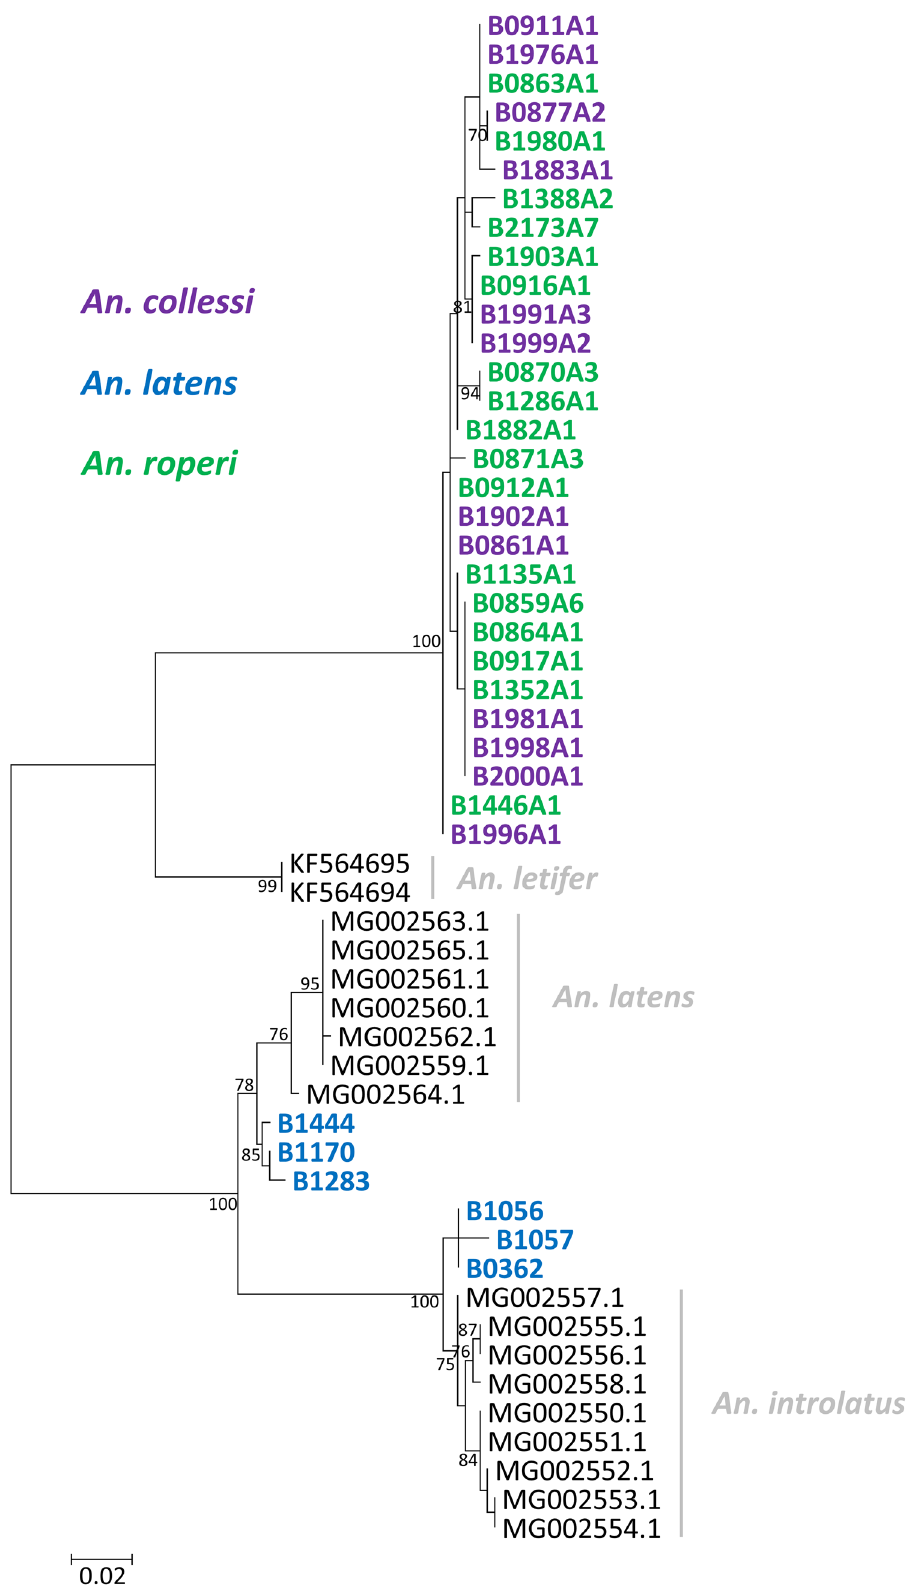
Figure 3. Phylogenetic tree based on the Anopheles COI gene using the ML method. The analysis was based in the Tamura-3 + G substitution model. Accession numbers of An. introlatus , An. latens , and An. letifer sequences obtained from GenBank are labelled in black while those derived from mosquitoes morphologically identified as An. collesi , An. latens and An. roperi are labelled in purple, blue and green respectively. The tree was generated with MEGA 7.0.21 (https:// www. megas oftwa re. net/) 57